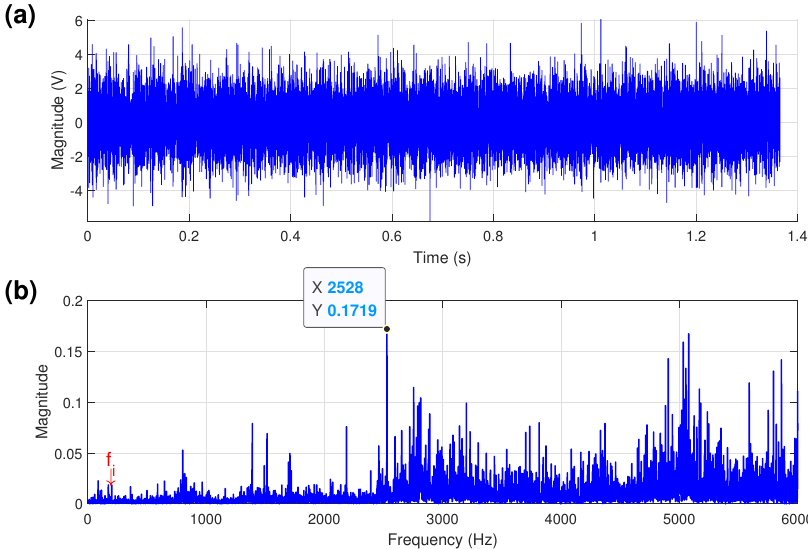
Figure 8. Faulty inner-race bearing: ( a ) time signal; ( b ) amplitude